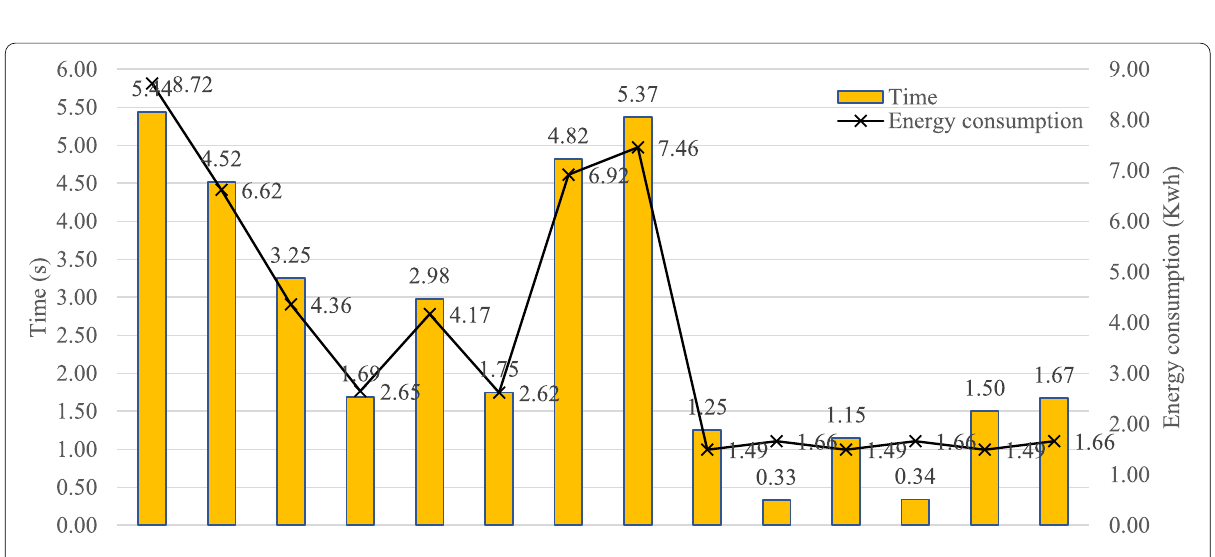
Figure 10 Energy assessment results of process